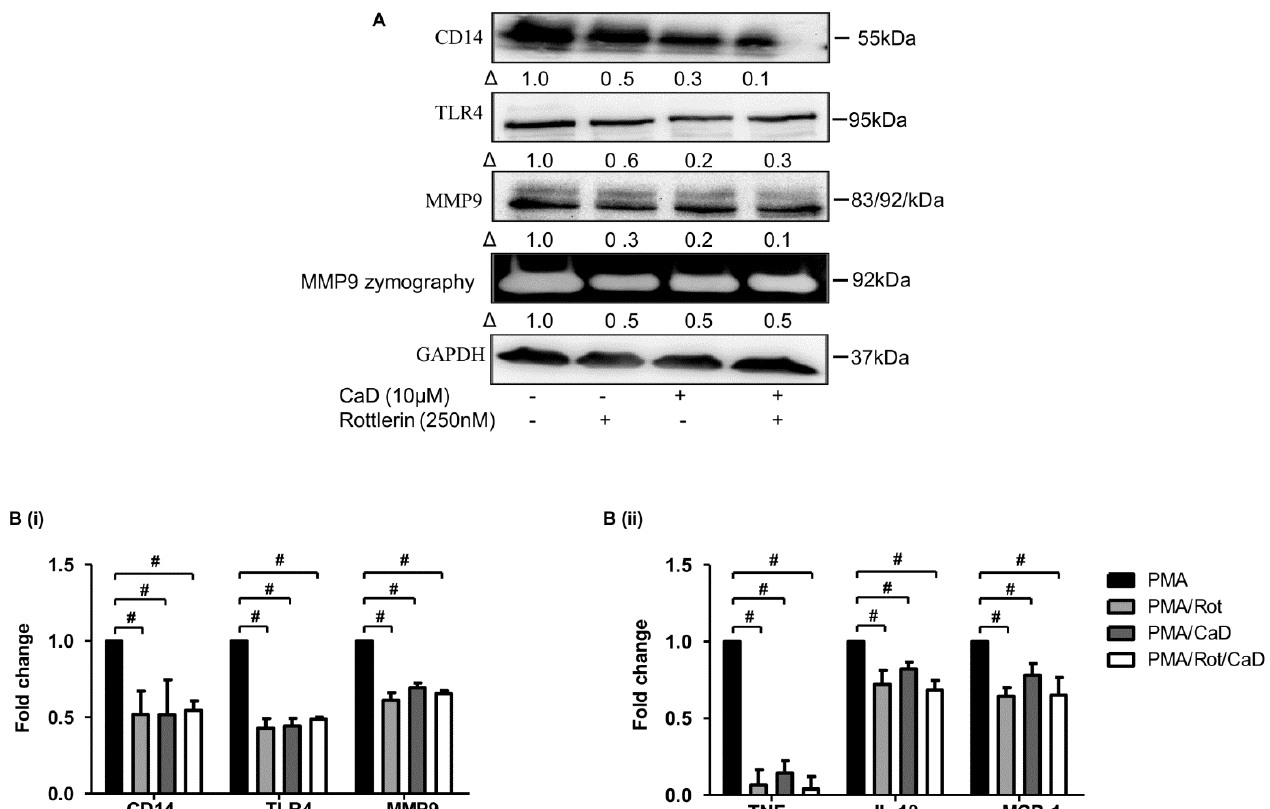
Figure 6. Inhibition of monocyte-to-macrophage differentiation and inflammation by CaD involves PKC δ -dependent signaling. THP-1 monocytes were pretreated with the PKC δ inhibitor rottlerin (Rot) for 1 h, followed by CaD for 1 h, and then treated with PMA (30 nmol/L) for 72 h. The differentiation and inflammation marker expression were measured by Western blotting ( A ), MMP9 activity measured by gelatin zymography, and transcript levels ( B ) measured by quantitative RT-PCR. Δ , fold-change normalized to PMA only ( n = 3, mean ± SEM. # p < 0.05 vs. PMA only, one-way ANOVA). The Western blot represents one from at least three independent experiments.